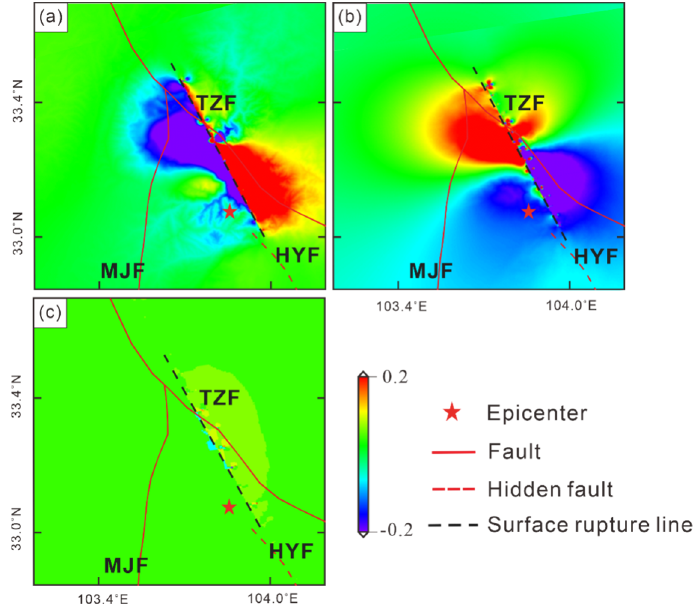
Figure 11. Three-dimensional coseismic deformation field of Jiuzhaigou earthquake. Panel ( a ) is the vertical component of the deformation field, ( b ) is the east–west component of the deformation field, and ( c ) is the north–south component of the decomposition of the deformation field. The black dotted line is the position of the surface rupture in this earthquake.